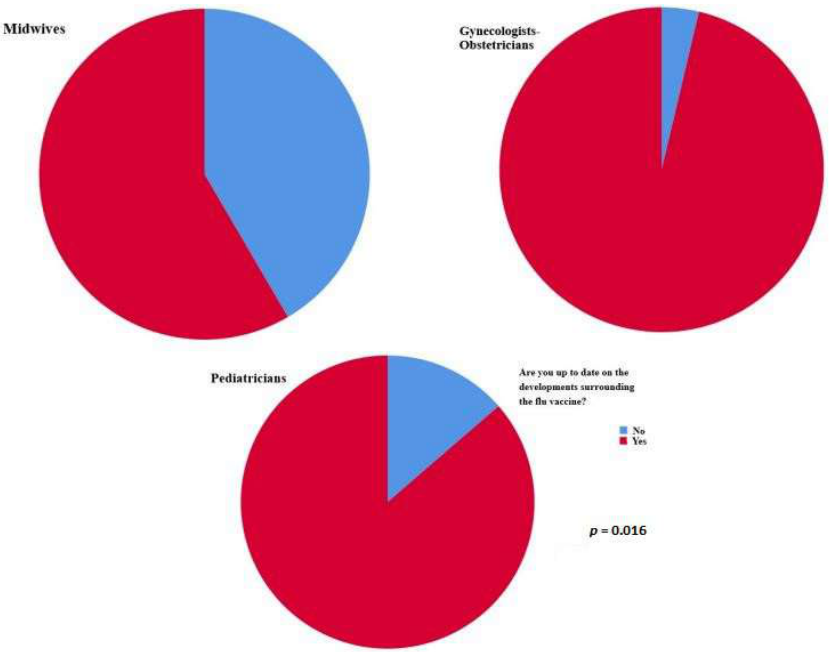
Figure 1. Most responders who mentioned that they were up to date on the developments surround- ing the flu vaccine were obstetricians–gynecologists ( p = 0.016). Pediatricians in our sample declared that vaccination is allowed for children older than six months ( p = 0.01). Midwife participants answered that vaccination is recommended throughout the entire pregnancy ( p = 0.02) (Figure 2).